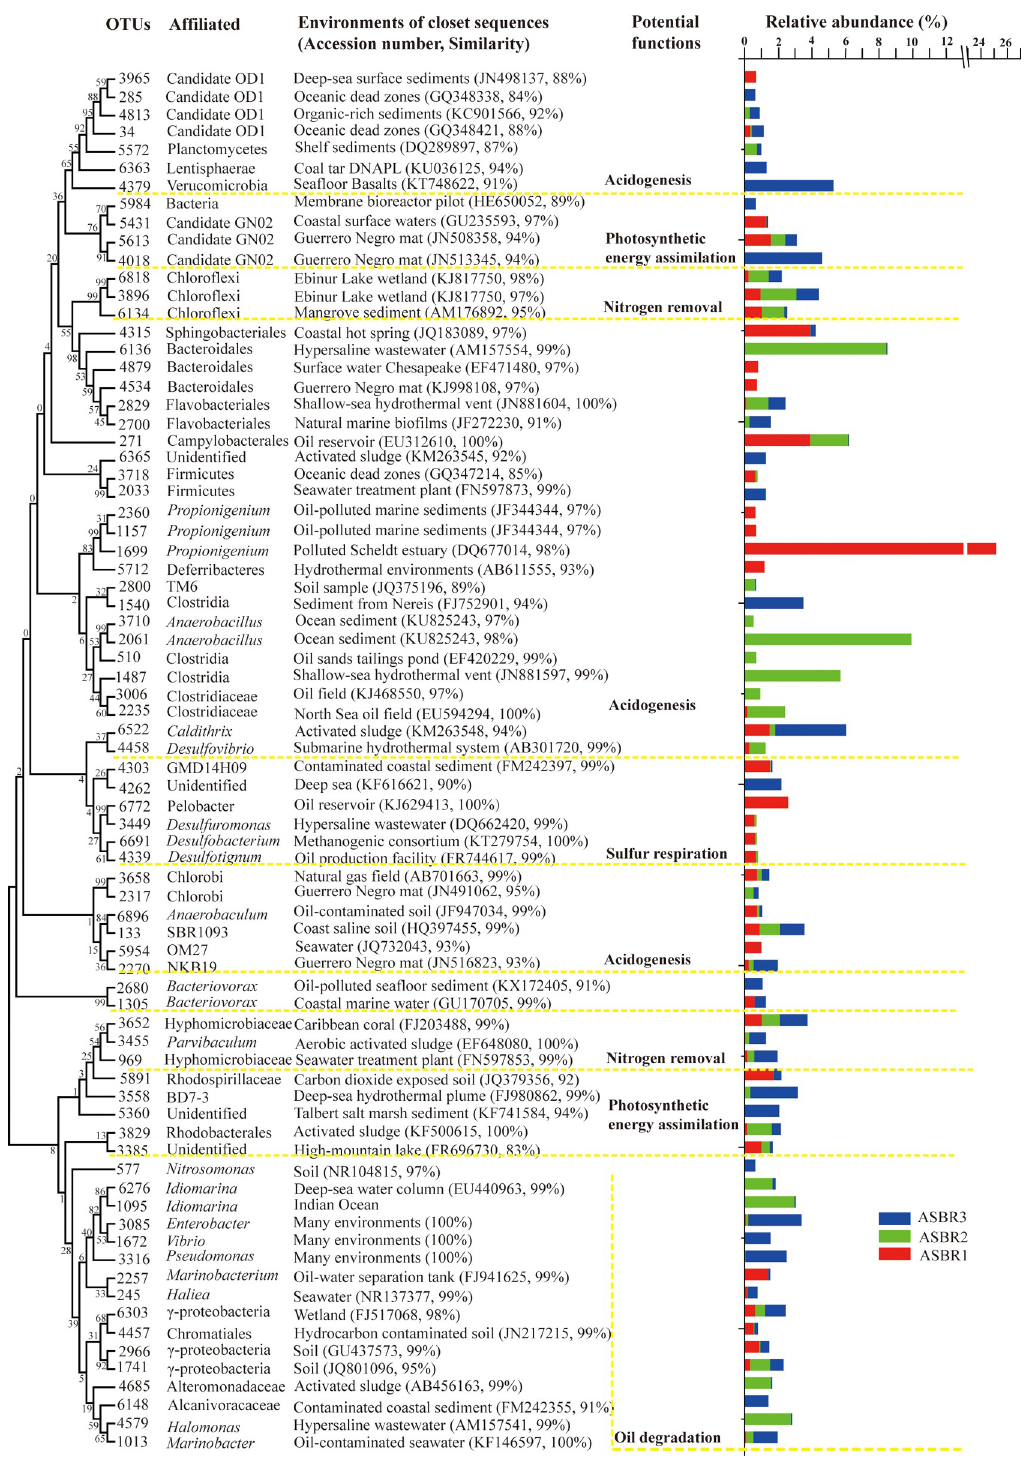
Fig 5. Bacterial phylogenetic tree of the dominant OTUs (relative abundance � 0.5%) in the three aerobic parallel reactors constructed by the neighbor-joining method. Potential function groups inferred from the relevant information extracted from NCBI database. Histograms showing the relative abundances (%) of reads of each dominant OUT detected in the three samples.